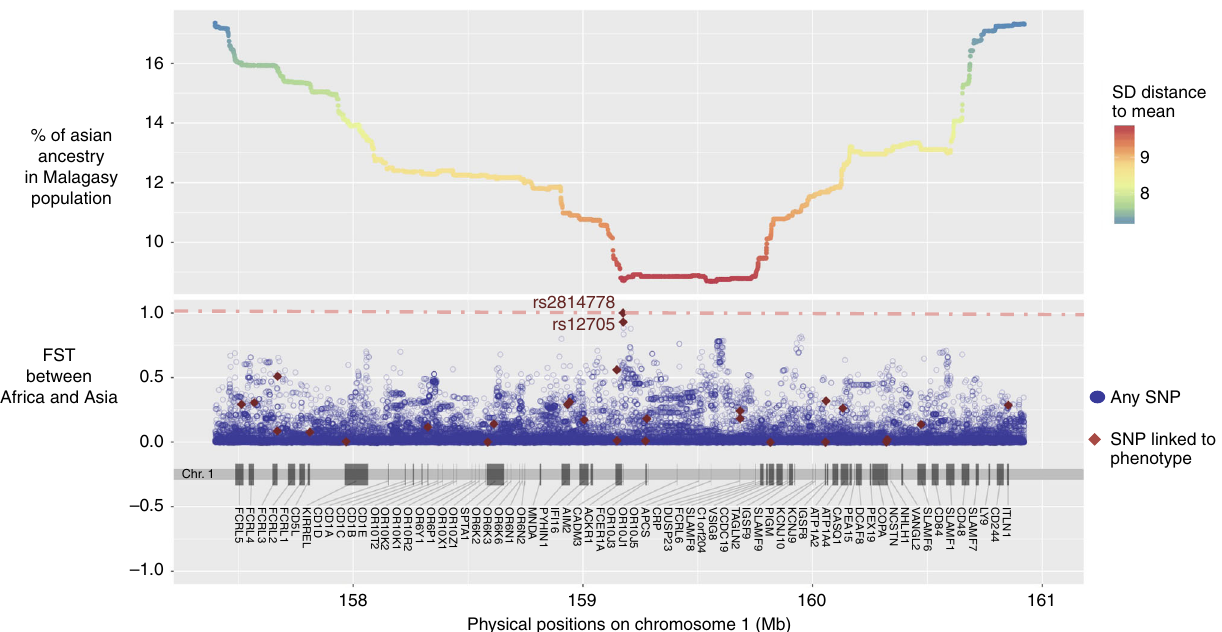
Fig. 5 Distribution of the amount of Asian ancestry across Malagasy individuals for the 1q23 chromosomal region, and the Fst value between Asian and African populations for each SNP. SNPs marked in red have been linked to a phenotype by